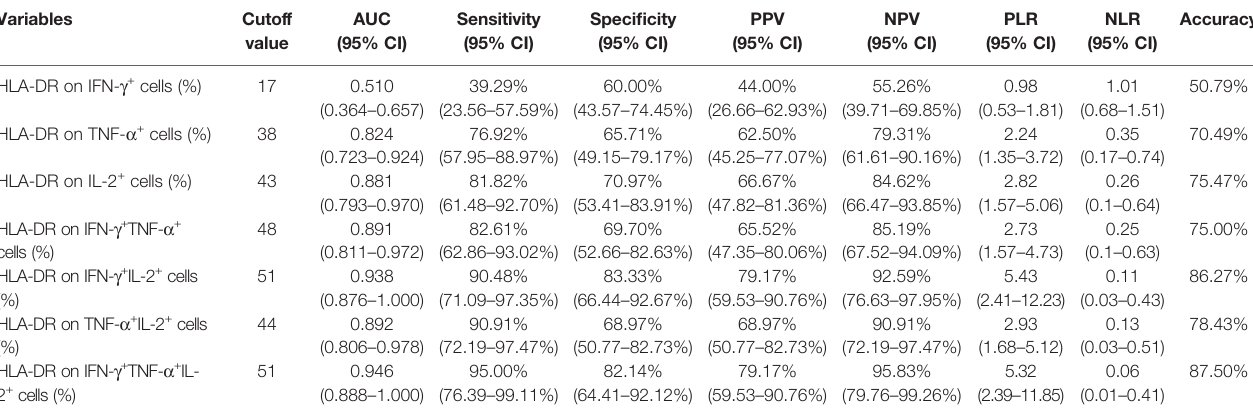
TABLE 3 | The performance of HLA-DR on MTB-speci fi c cells for distinguishing between ATB and LTBI in Caidian cohort.